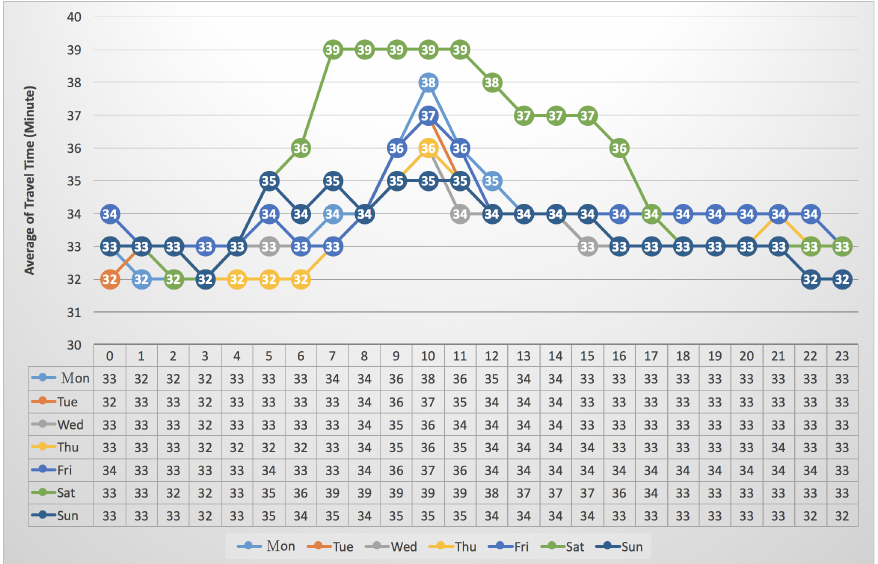
Figure 14. The average of travel time of vehicles in the southern (S) direction vs. “24 h per day” and “seven days per